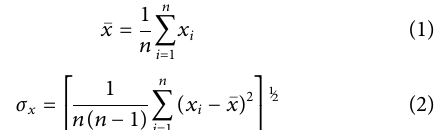
Absorbance of nano-LiBr with E414.